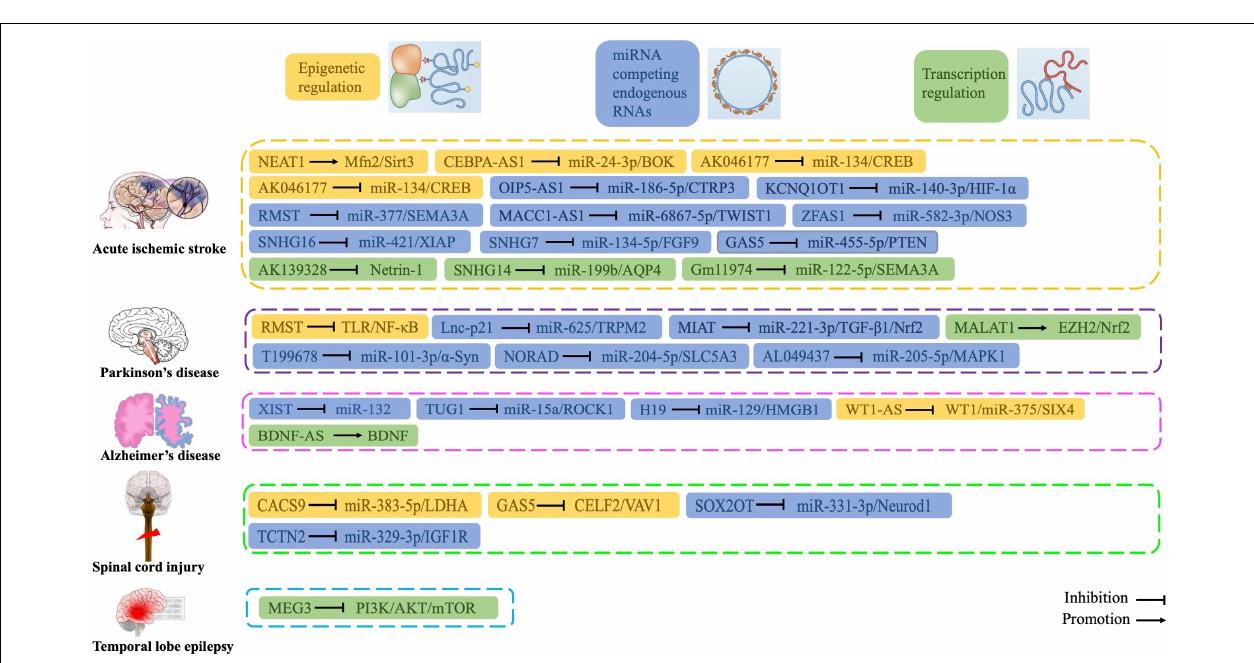
FIGURE 5 | Roles and functions of lncRNAs in regulating oxidative stress during central nervous system